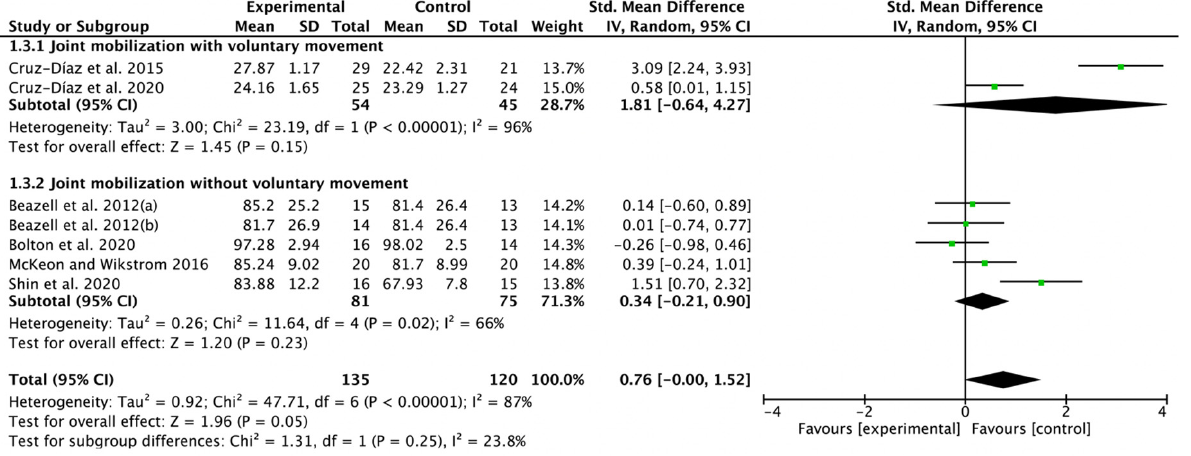
Figure 5. Forest plot on the effect of joint mobilization on function. Beazell et al. 2012(a) [18], proximal tibiofibular joint mobilization; Beazell, et al. 2012(b) [18], distal tibiofibular joint mobilization. Cruz- D í az et al. 2015 [19], Cruz-D í az et al. 2020 [17], Bolton et al. 2020 [23], McKeon and Wikstrom 2016 [21], Shin et al. 2020